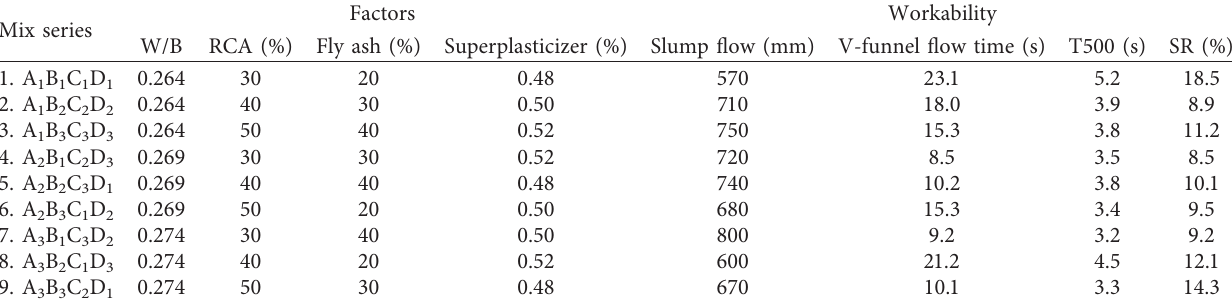
Table 9: Workability test results.